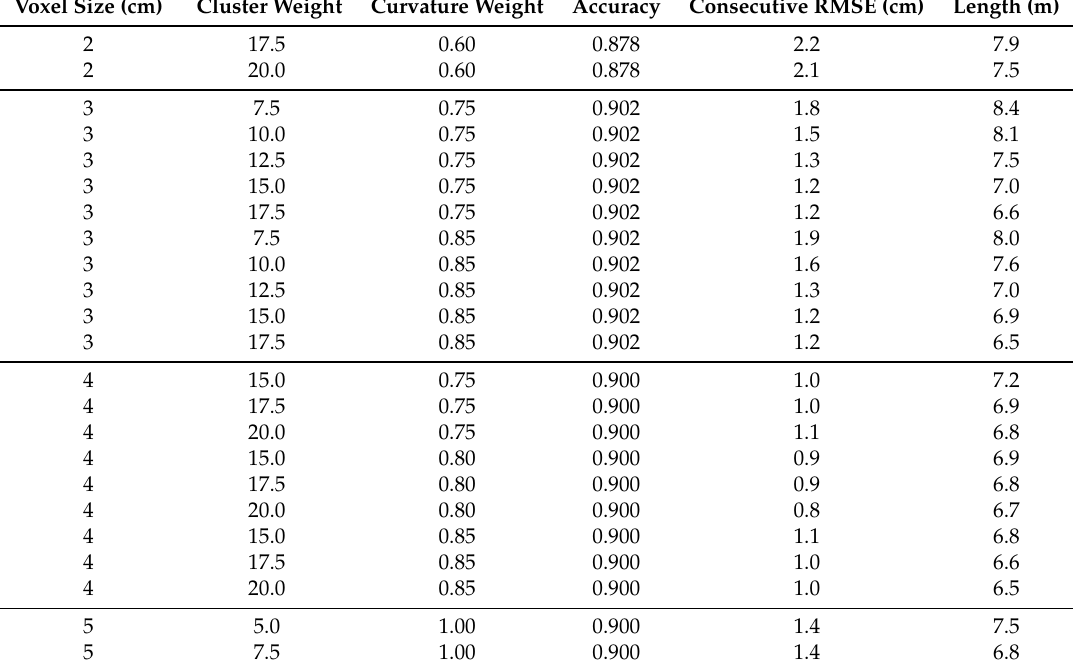
Table 4. Maximum accuracy values for each voxel size and a plot of a radius of 10 m. For each voxel size, there are a number of weight settings from the parameter study that gave equally large maximum accuracy values.